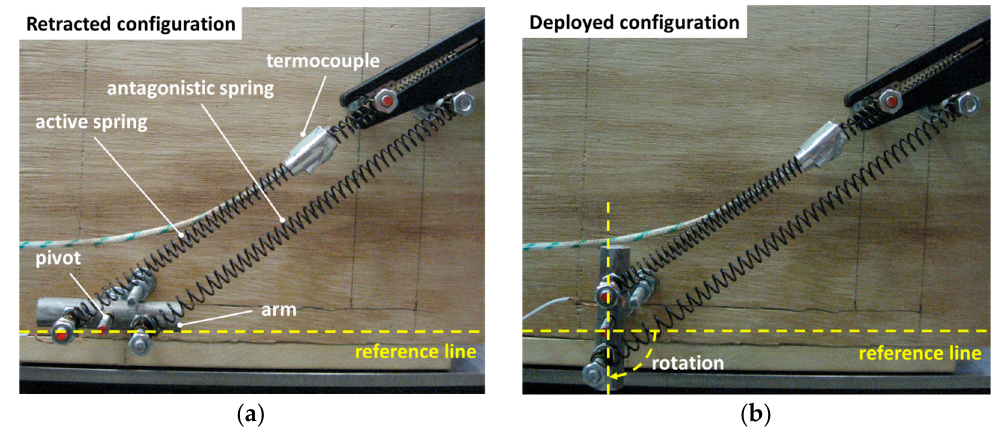
Figure 11. Test specimen: retracted ( a ) deployed configuration ( b ).